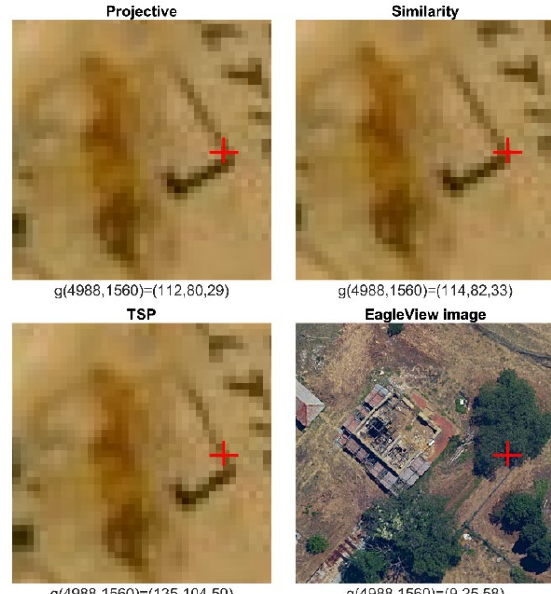
Figure 8: Positional accuracy assessment of the historical maps using Nairn